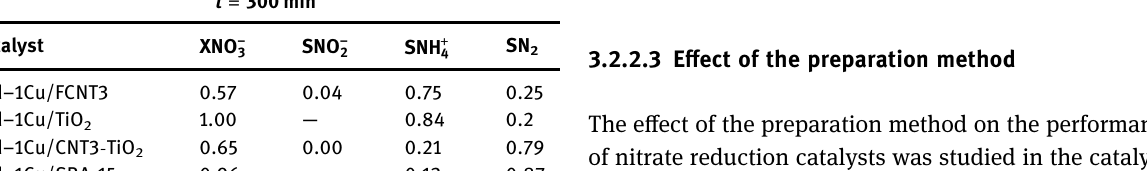
= 30 ppm, C = 0.5 g/L, catalyst 3 −